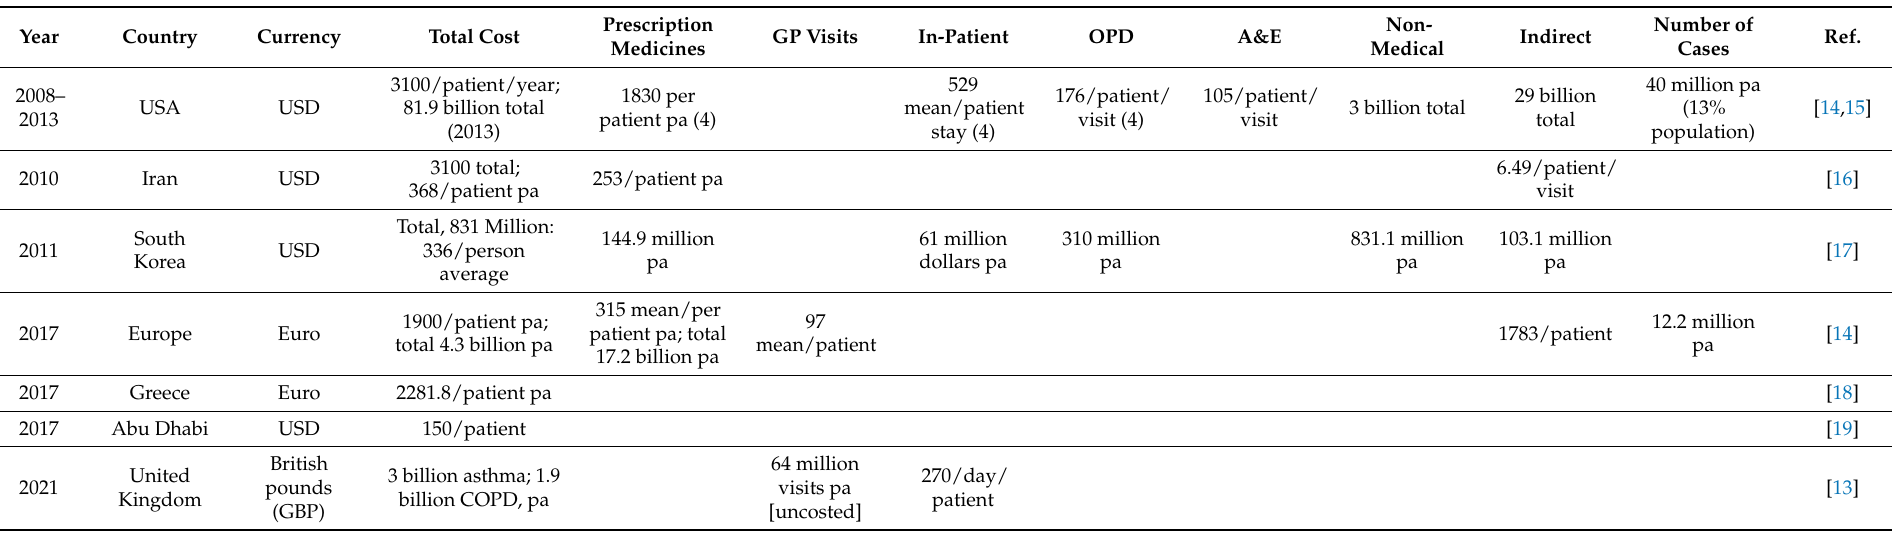
Table 1. Costs of asthma per patient and per year in literature